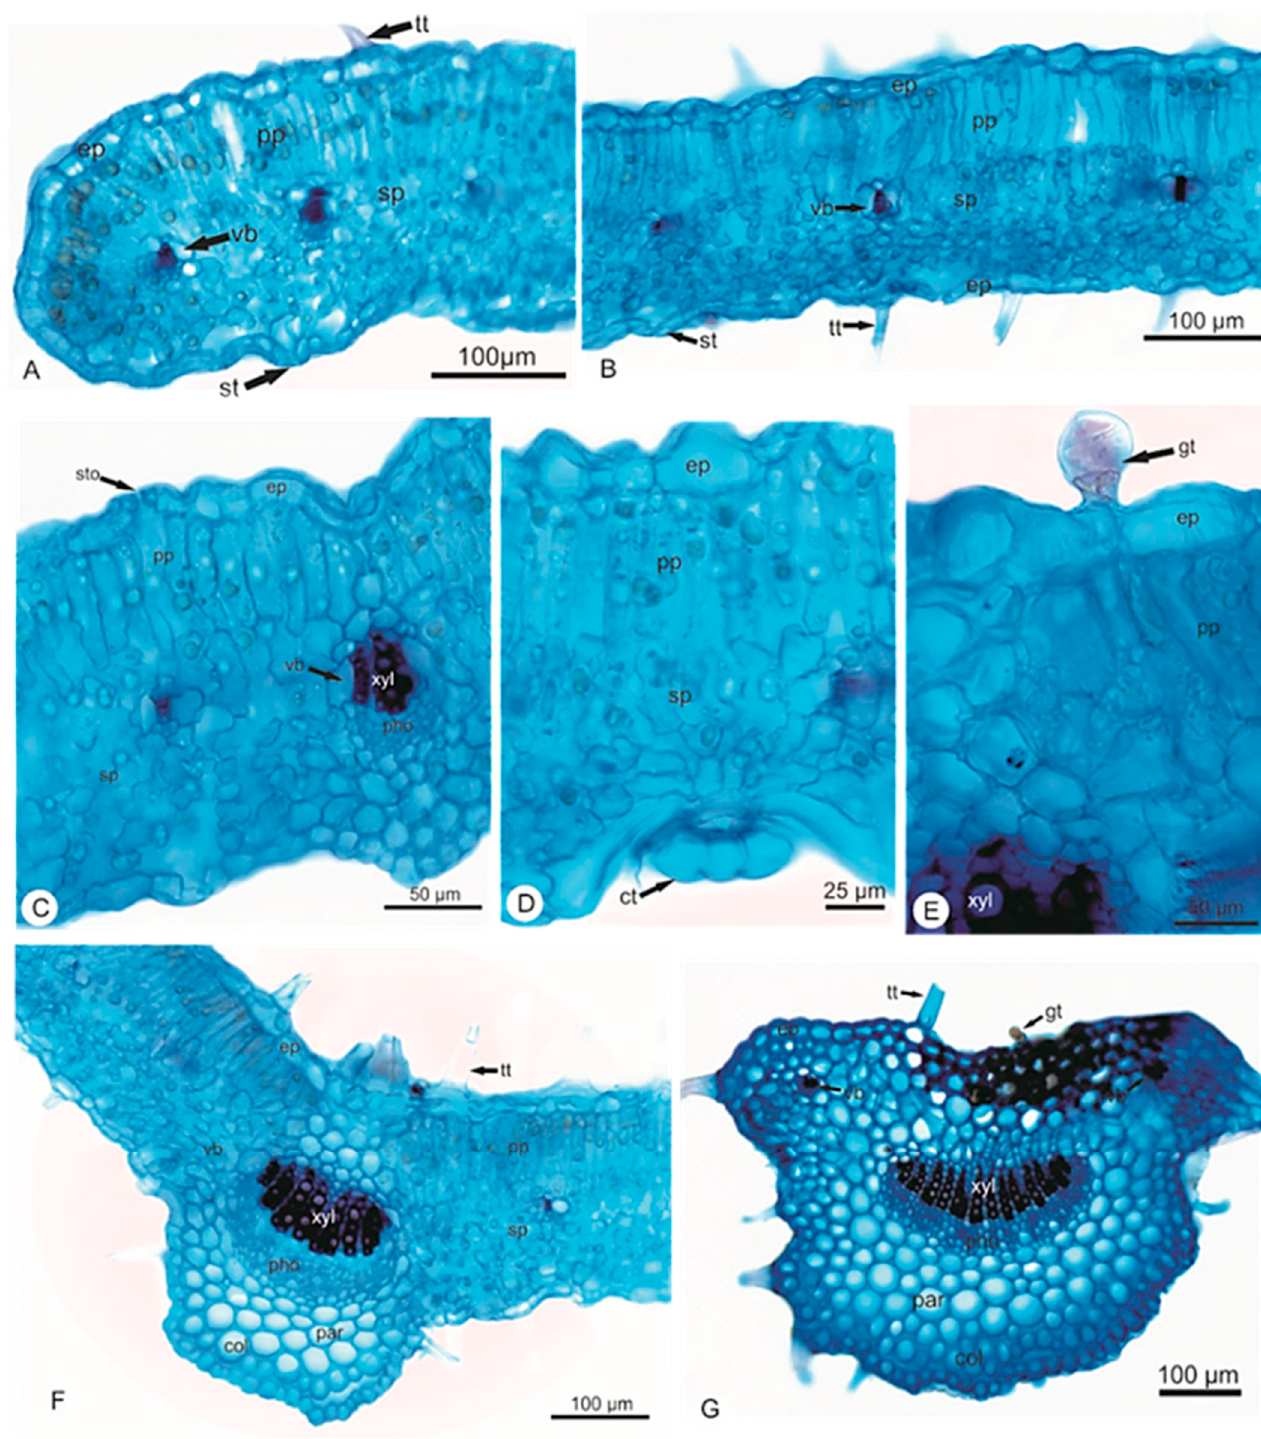
Figure 2. Cross sections of leaf of Elsholtzia ciliata (Thunb.) Hyl. ( A ) Margin with circular contour, presence of multicellular tector trichome; ( B ) Mesophyll dorsiventral with small collateral vascular bundles; ( C ) Detail of mesophyll with uniseriate epidermis, uniseriate palisade parenchyma and several layers of spongy parenchyma; ( D ) Detail of mesophyll with capitate glandular trichome present in the abaxial surface; ( E ) Detail of glandular trichome present in the adaxial surface; ( F ) Midrib has concave–convex contour and one collateral vascular bundle; ( G ) Petiole with plan-convex contour, with one larger bundle in the central portion and two smaller bundles. Legend: collenchyma (col); capitate glandular trichome (ct); epidermis (ep); peltate glandular trichome (gt); parenchyma (par); palisade parenchyma (pp); phloem (pho); spongy parenchyma (sp); stomata (st); tector trichome (tt); vascular bundle (vb); xylem (xyl); Stomata (sto).